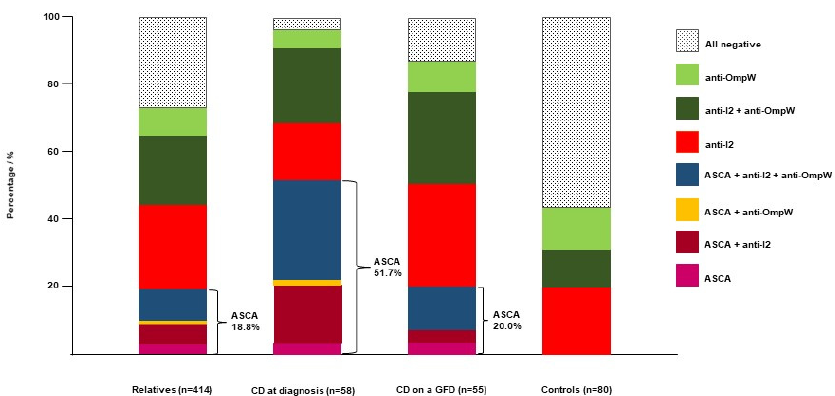
Figure 1. Distribution of seropositivity to antibodies against Saccharomyces cerevisiae (ASCA), Pseudomonas fluorescens -associated sequence (anti-I2 antibodies) and Bacteroides caccae TonB-linked outer membrane protein (anti-OmpW antibodies) among autoantibody-negative relatives of celiac disease (CD) patients, CD patients (at diagnosis and on a GFD) and controls.